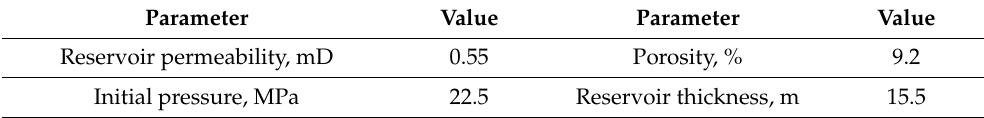
Table 2. Reservoir parameters of well A.